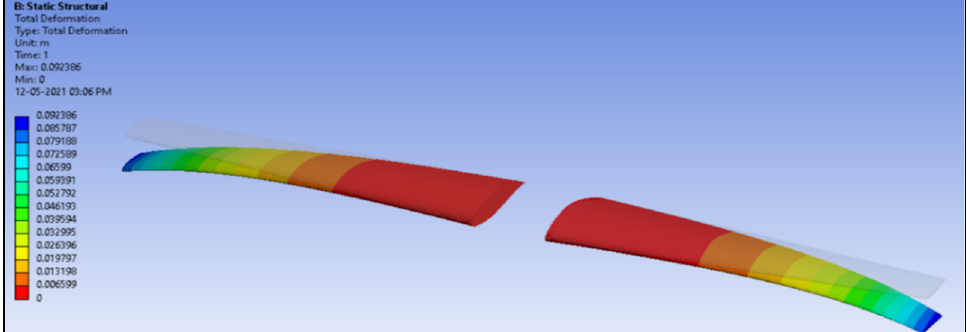
Figure 33. Deformation of wing subjected to 100 kN bending load.